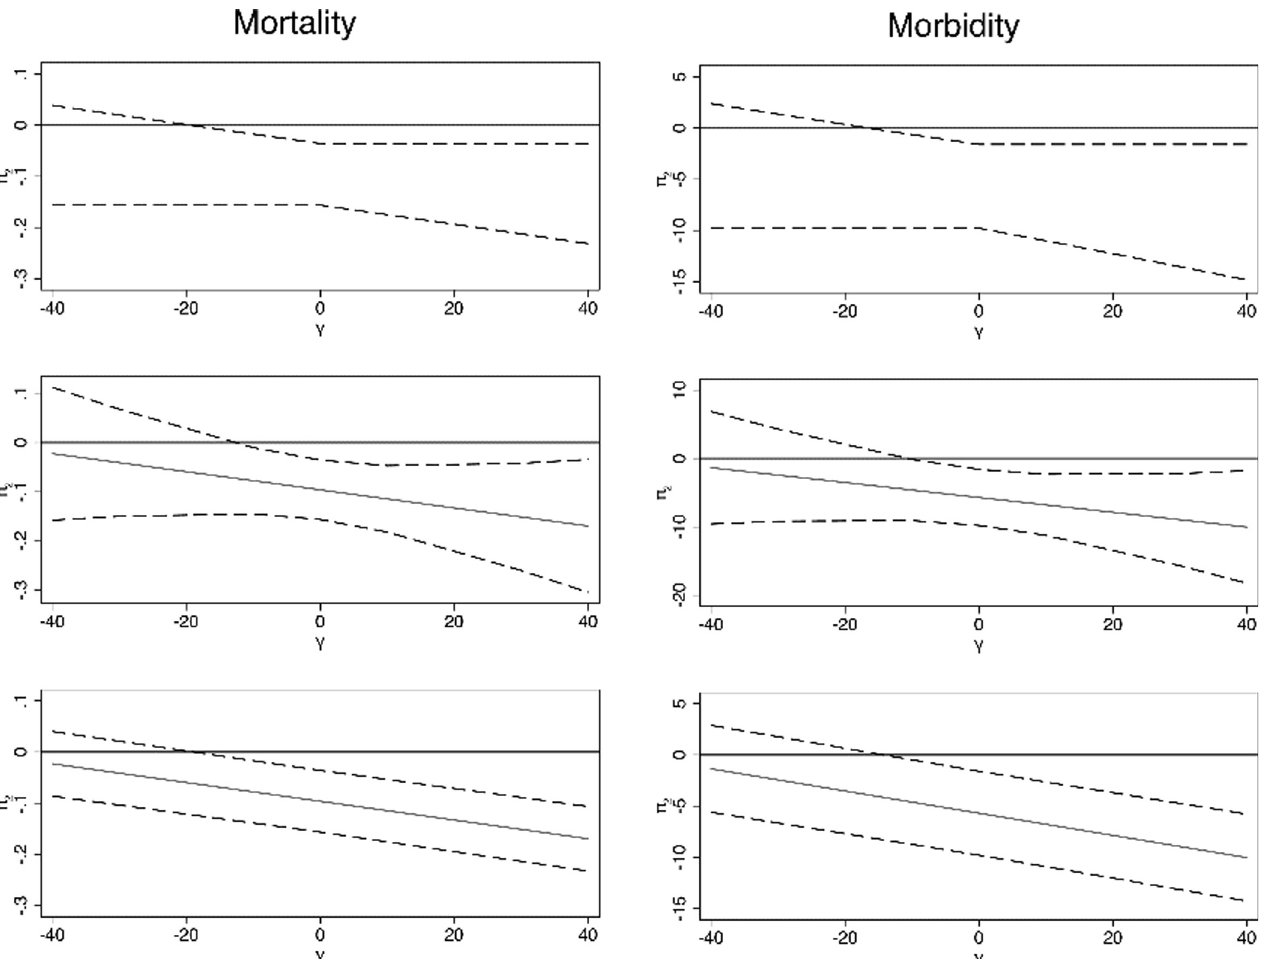
Fig 1. A. Small violations of the exogeneity assumption on the effect of mortality (Conley et al. 2012). B. Small violations of the exogeneity assumption on the effect of DALY (Conley et al. 2012). Note: upper panel: union of confidence interval approach; middle panel: local to zero approach with variance equal to the square of the mean; lower panel: local to zero approach with variance equal to the mean. π 2 is the real causal effect of mortality on GPD per capita growth and γ is the direct effect of the instrument on GDP per capita growth.